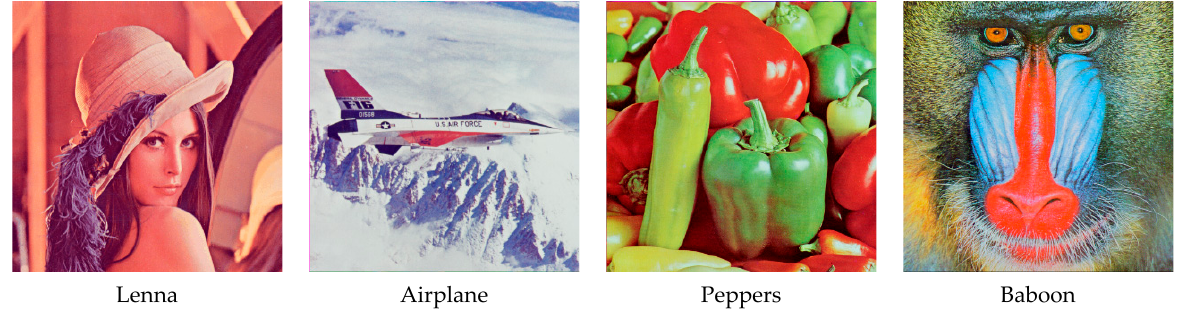
Figure 14. Four test images. Table 4. Resulting CR, PSNR, and BPP using the test images in Figure 14.